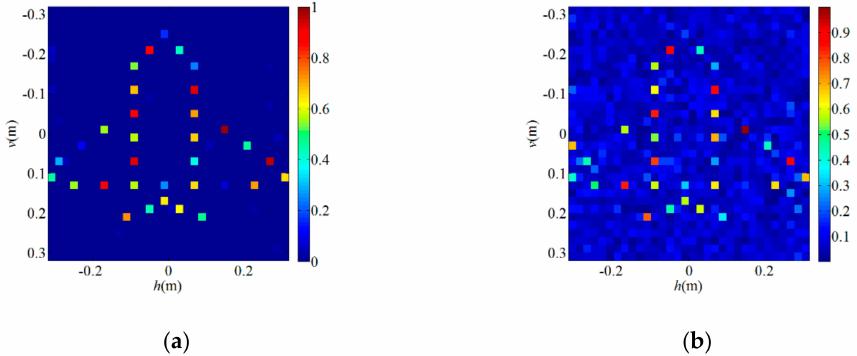
Figure 6. Performance results of the SWFOS algorithm and the WFOS algorithm in the PL-TCAI system.